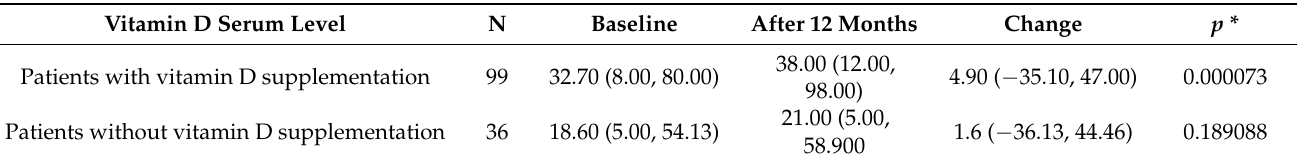
Table 4. Median values of 25(OH)D serum levels at baseline and after 12 months of observation among patients with MS.